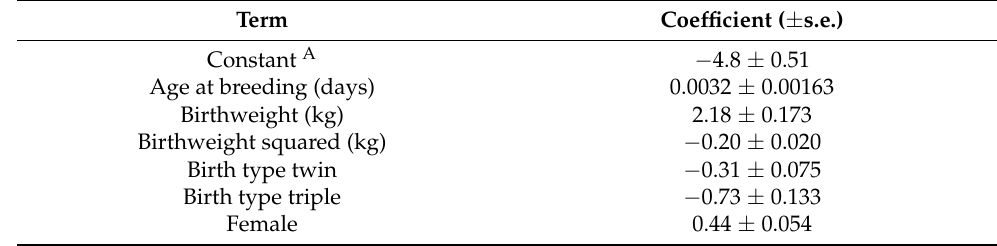
Table 6. Regression coefficients ( ± s.e.) of General Linear Mixed Model analysis that predicts survival to weaning of individual offspring in terms of age of maternal composite ewe lambs at breeding and offspring birthweight, birth type and sex. Data represent a combined analysis across all years and data were transformed (logit). All terms are significant ( p < 0.001), except age at breeding ( p = 0.05). Term Coefficient ( ± s.e.) Constant